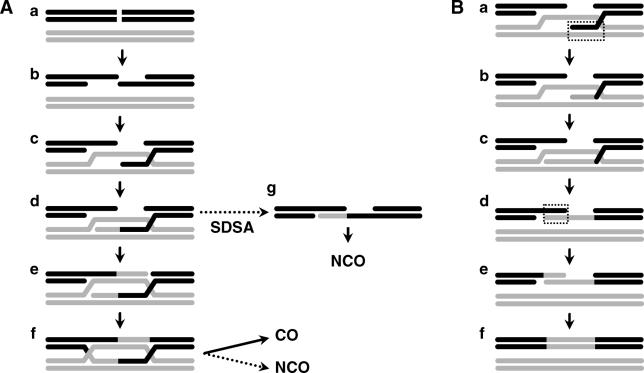
Meiotic Recombination Models(A) Model for the formation of crossovers (CO) and noncrossovers (NCO). Recombination is initiated with a DSB (a), that is resected to generate 3′ single-stranded ends (b). A 3′ end invades the homologous chromosome (c) and primes repair DNA synthesis (d). If repair synthesis proceeds far enough, second-end capture can occur (e). After repair synthesis from the second end, ligation of newly synthesized 3′ ends to resected 5′ ends results in a DHJ intermediate (f). Resolution of the DHJ can generate a CO or a NCO. In SDSA, the nascent strand dissociates after repair synthesis and anneals to the second broken end (g). Gap filling and ligation generates an NCO. Note that NCO products can come from either a DHJ intermediate or SDSA, or both.(B) Sources of gene conversion. hDNA is first generated during strand invasion (a, dotted box); mismatch repair may replace the invading sequence with the sequence of the template (b). After synthesis (c) and dissociation, annealing of the nascent strand to the other end of the break also generates hDNA (d), which can also be acted on by mismatch repair (e). The final NCO product in this example (f) has a region of gene conversion derived from two rounds of mismatch repair, but one round is sufficient to generate a gene conversion. Also, mismatch repair can act on the DHJ intermediate (A) or the products of DHJ resolution, and thus gene conversion can also be associated with crossing over.